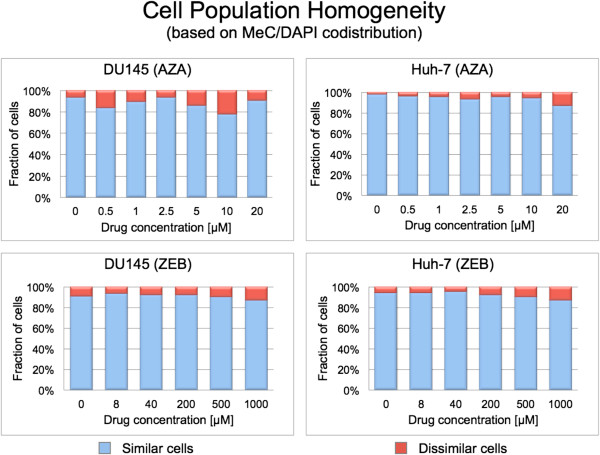
Cell population homogeneity measurement. Left diagram (different drugs): normalized proportions of the different cell populations (n ≈ 300 is the number of cells analyzed for each category); untreated control cells show a high fraction (≥ 95%) of pooled similar cells (KL < 4.5); this is true also for the majority of drug concentrations with both cell types (similarity on average ≥ 90%); the lowest homogeneity values being still relatively high at 82% for DU145/0.5 μM AZA and 79% for DU145/10 μM AZA. For simplification purposes, the rest of the cells were summarized as dissimilar cells (KL ≥ 4.5) in this display.